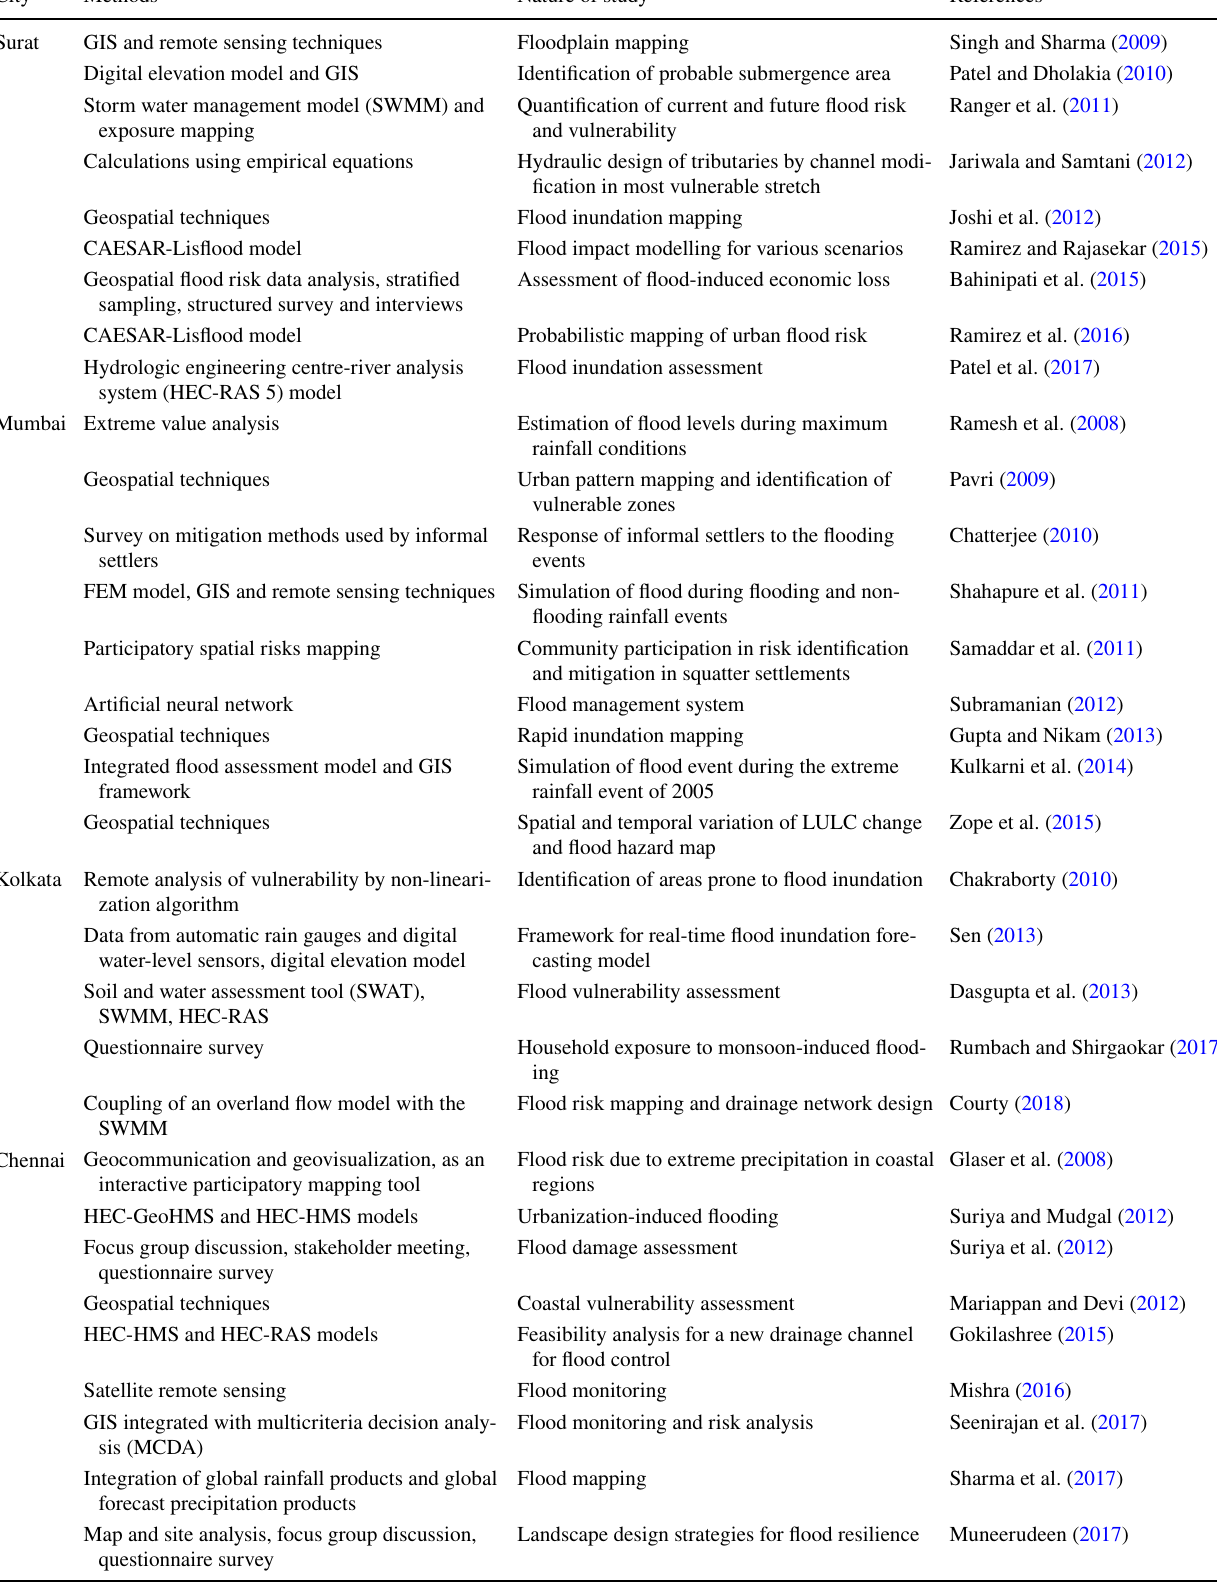
Table 2 Comparative assessment of different approaches for flood risk